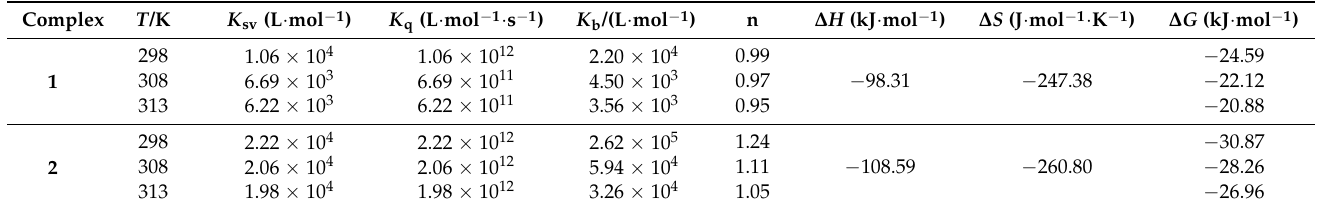
Table 4. K sv , K q , K b , n values, and thermodynamic parameters for complex-BSA systems at three different